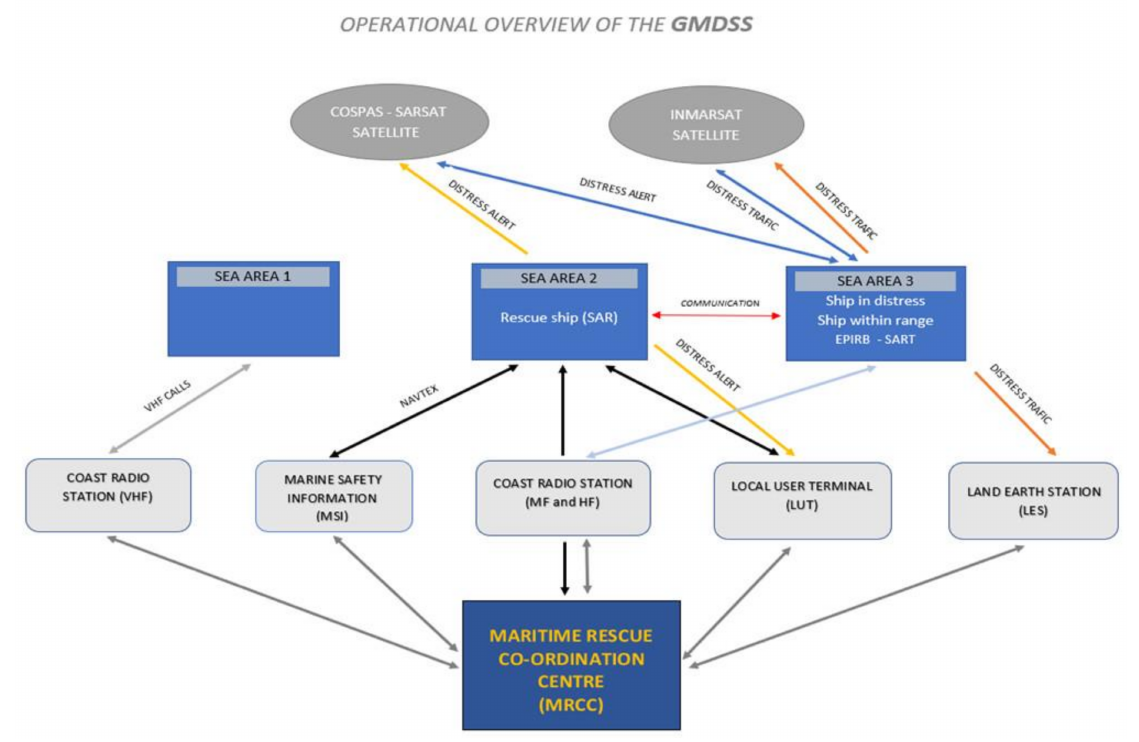
Figure 1. GMDSS communication used on a ship.